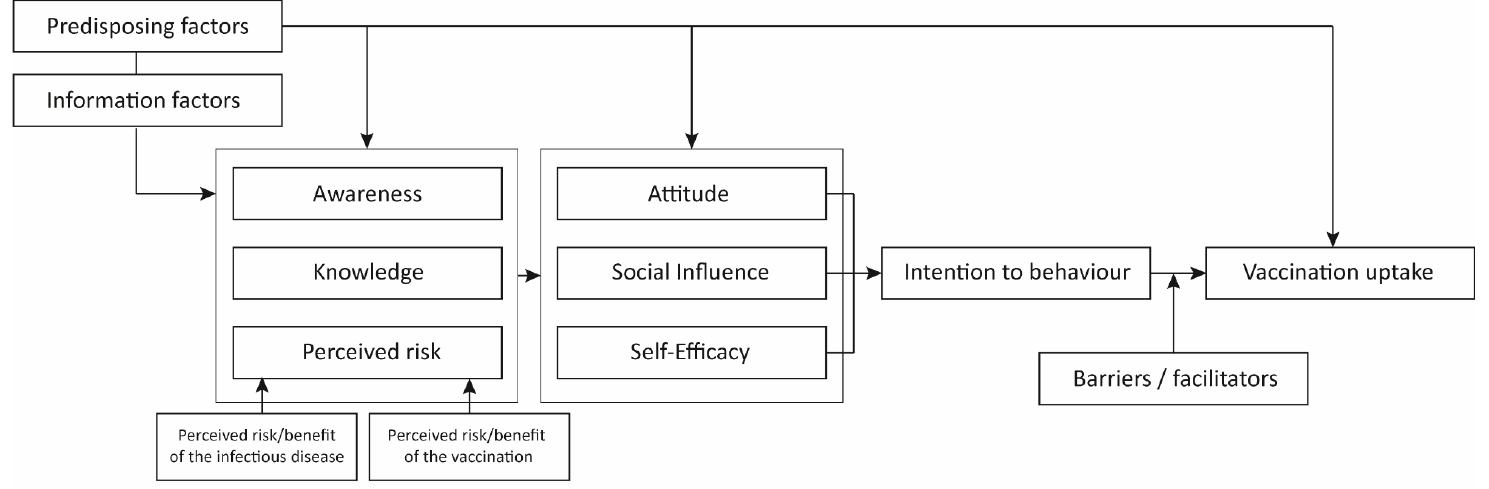
Figure 1. Simplified I-Change model summarizing the studied determinants that could predict vaccination uptake. We used a simplified version of the I-Change model applied to vaccination uptake. Uptake is shaped by the intention to get vaccinated which is subject to barriers and facilitators. Intention is established by motivation (attitude, social influence, and self-efficacy), awareness (awareness, knowledge, and perceived risk) and information and predisposing determinants. Predisposing factors include baseline characteristics of studied populations and influence awareness, motivation and uptake. Information factors include information retrieved via media, social contacts and healthcare workers.